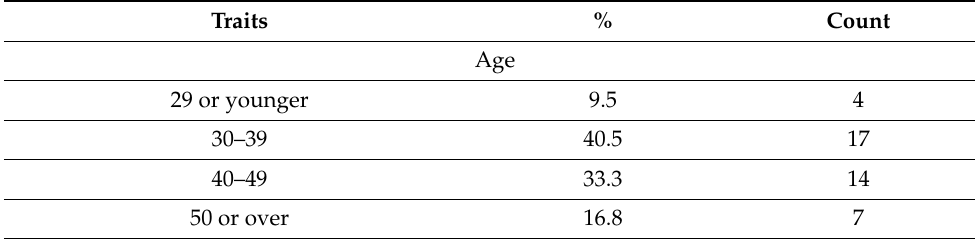
Table 1. Characteristics of study